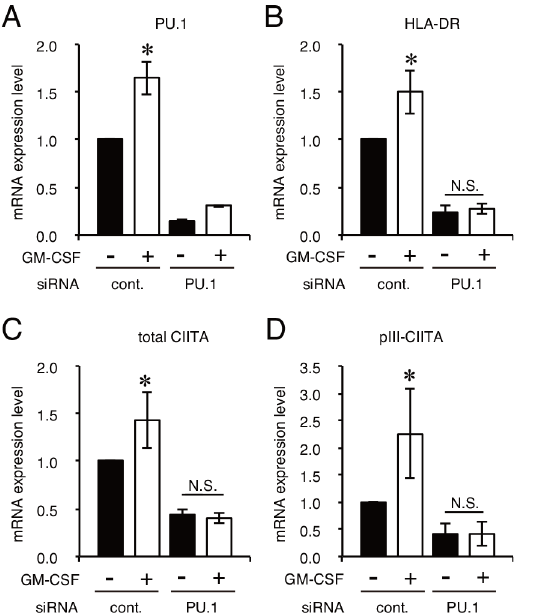
Fig 6. PU.1 knockdown cancels GM-CSF-mediated increase of mRNAs. A-D. Quantitative real-time PCR analysis of the mRNA expression of PU.1 (A), HLA-DR α (B), total CIITA (C), and CIITA driven by pIII (D) in PU.1 siRNA (PU.1)- or control siRNA (cont.)-introduced CAL-1 cells. Cells were incubated for 24h after siRNA transfection and cultured for additional 72h with GM-CSF stimulation. The results are expressed as means ± SEMs of three independent experiments. Each experiment was performed with duplicate samples. * , p <